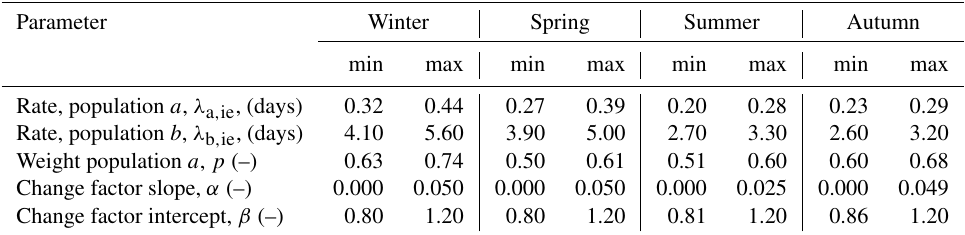
Table 5. Ranges of accepted parameter values for the mixed exponential distribution applied to sampling inter-event times and for the linear function applied to sample change factors for each season.